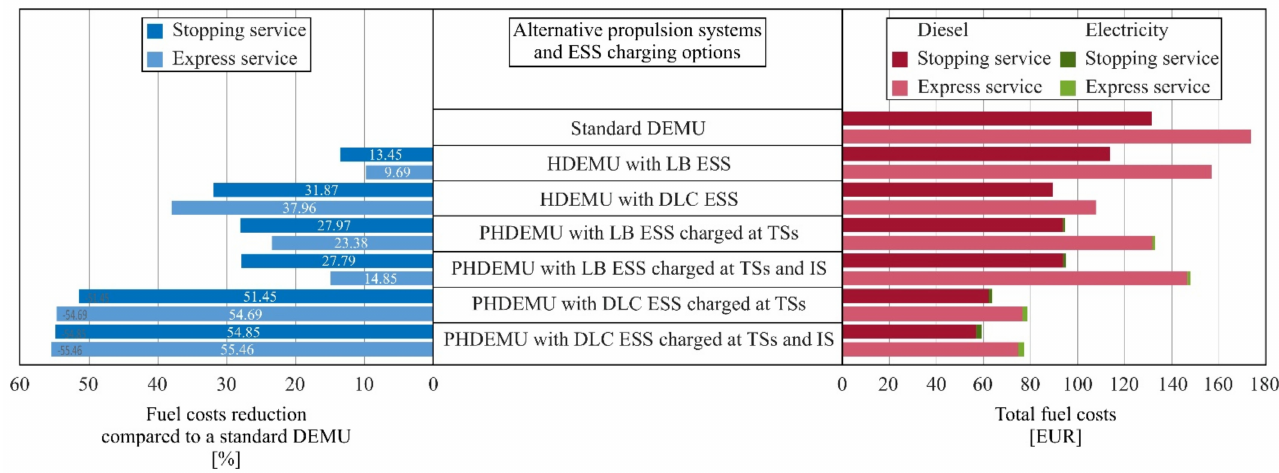
Figure 10. Estimated fuel costs for different propulsion system and charging location configuration, and potential reduction compared to a standard diesel-electric multiple